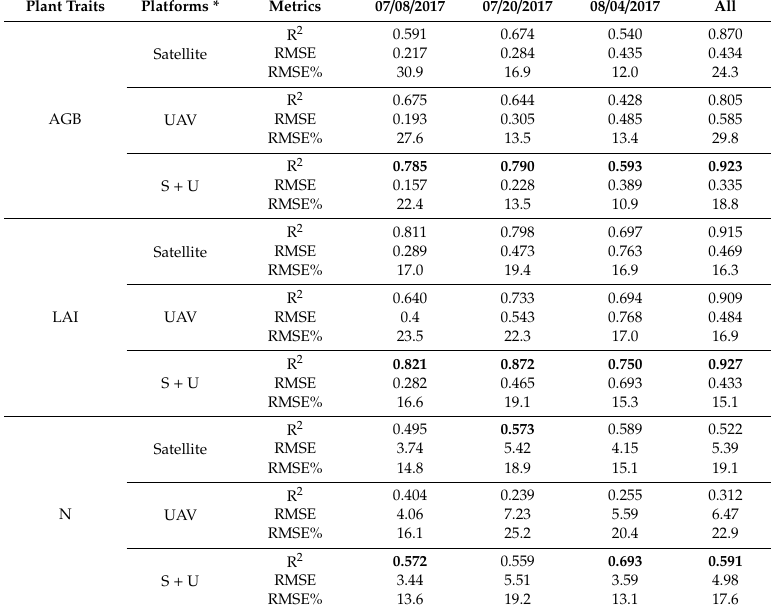
Table 7. Testing results for AGB, LAI, and N estimation at di ff erent development stages using the ELR method.